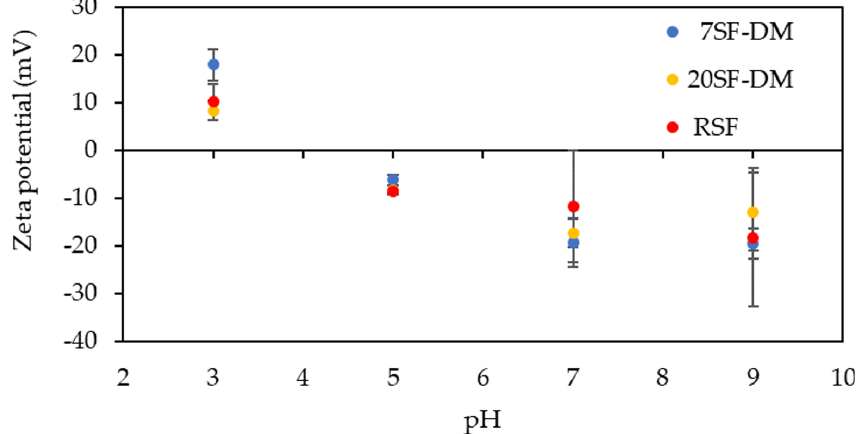
Figure 2. Zeta potential of fractionated SF-coated